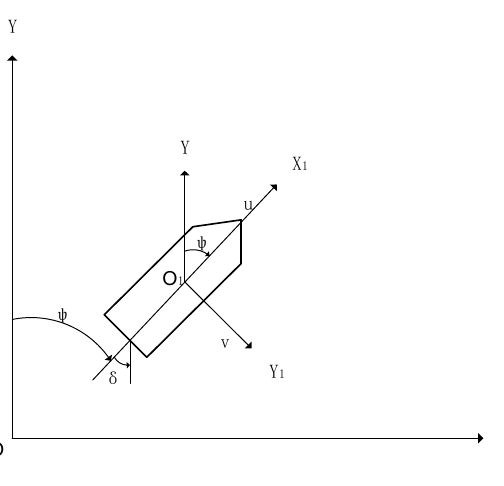
Figure 1. Coordinate system of ship.